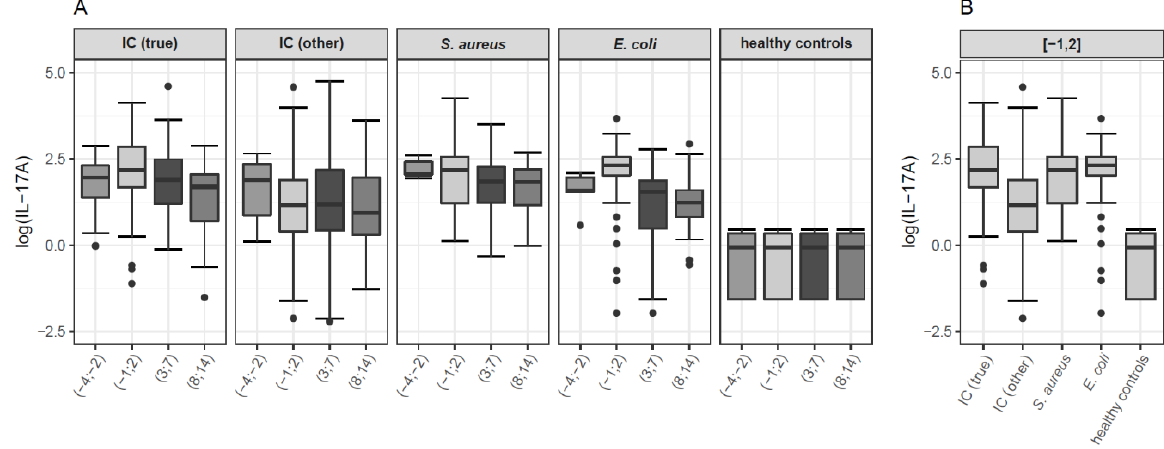
Figure 1. Boxplots of interleukin 17A (IL-17A) values of the investigated study groups for each time interval ( A ), and with focus on time interval (−1; 2) ( B ) for the total study population. IL-17A values (pg/mL) are depicted on the logarithmic scale. In the boxplots, median values are depicted as bold line and the box spans from first to third quartile; whiskers extend to a maximum of 1.5 times the interquartile range (IQR, third minus first quartile) out from the respective box end; all remaining values are indicated as dots. Time intervals represent study days. Time interval (−1; 2) includes blood samples collected one day prior until up to two days after collection of the index sample. IC = invasive candidiasis. IC (true) = patients with true candidemia ( n number of patients in boxplot B = 46, n number of samples in boxplot B = 97). IC (other) = patients with candidemia of unclear significance (positive blood cultures from central veins only), proven IC other than candidemia, and patients with probable and possible IC ( n number of patients in boxplot B = 41, n number of samples in boxplot B = 81). S. aureus = patients with S. aureus bacteremia ( n number of patients in boxplot B = 22, n number of samples in boxplot B = 45). E. coli = patients with E. coli bacteremia ( n number of patients in boxplot B = 27, n number of samples in boxplot B = 48).